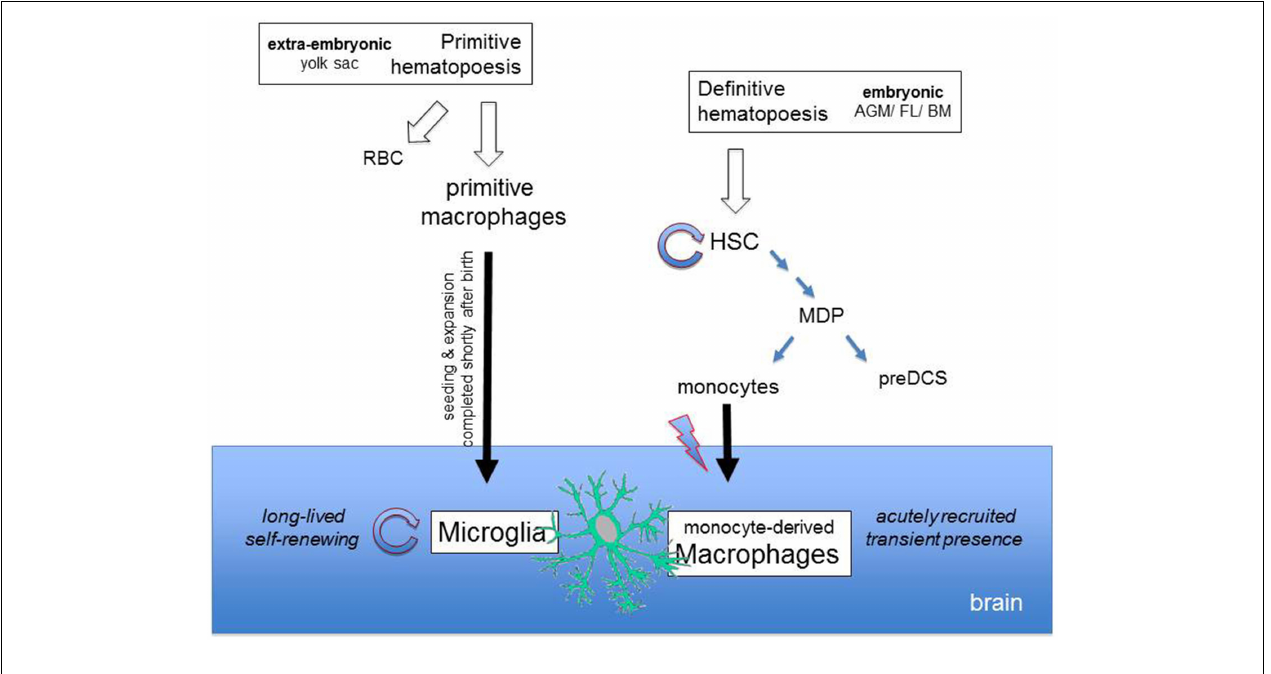
brain recruits monocytes that differentiate locally into monocyte-derived macrophages and transiently complement the brain mononuclear phagocyte compartment. Monocytes are generated in the BM from macrophage-DC precursors (MDPs) that are constantly replenished from self-renewing hematopoietic stem cells (HSCs) which arose from definitive